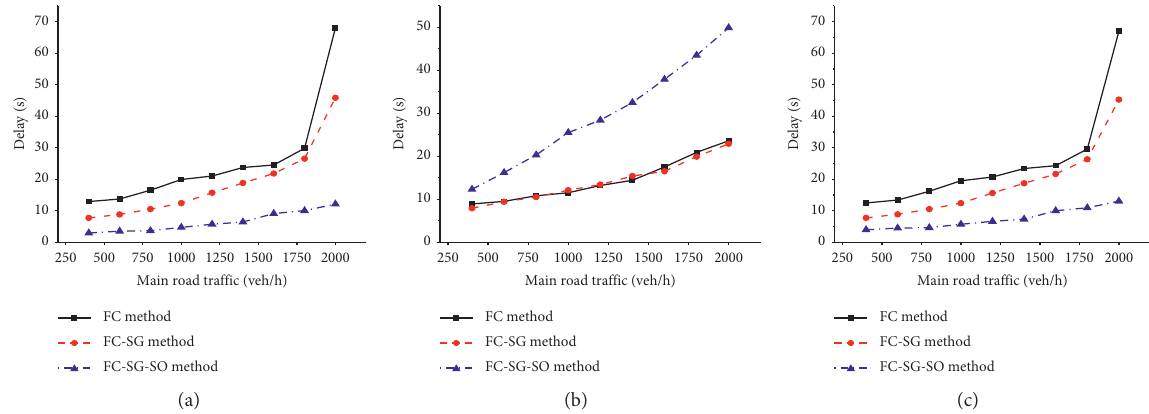
Figure 6: Delays under different traffic volumes of main road. (a) Main road delay. (b) Secondary road delay. (c) Total delay.